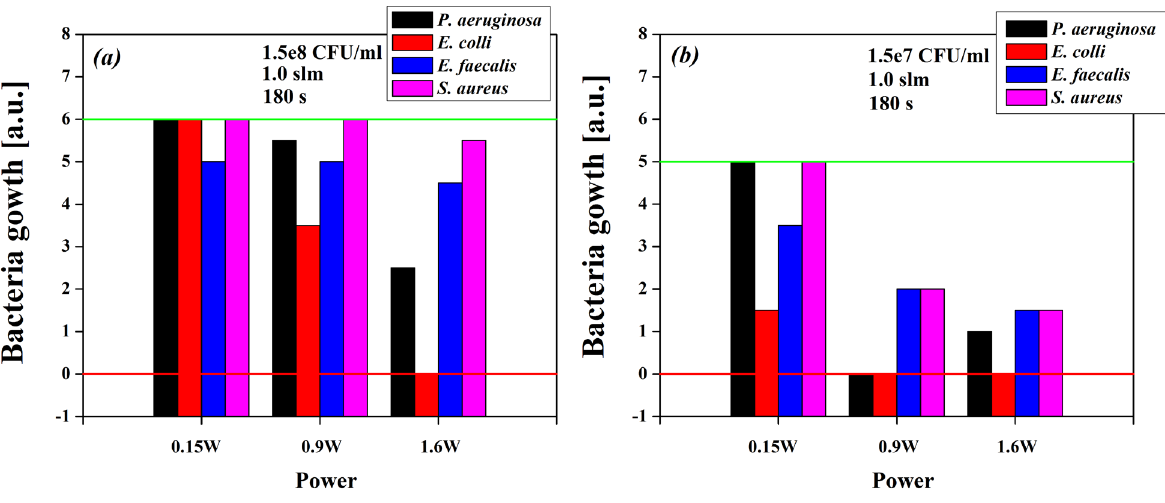
Figure 7: Sterilization of four different strains of bacteria: Enterococcus faecalis ATCC 29212, Pseudomonas aeruginosa ATCC 27853, Escherichia coli ATCC 25922 and Staphylococcus aureus ATCC 25923. More detailed data for the Escherichia coli and Staphylococcus aureus are given in [20]. Here, a part of the data from [20] are given for clearer comparison between plasma effect on Gram positive and Gram negative bacteria. The flow of helium was 1 sLm and the treatment time 180 s. Green line represents untreated control values and red line represents complete sterilization of the sample. (a) concentration 1.5×10 8 CFU mL -1 ; (b) concentration 1.5×10 7 CFU mL -1